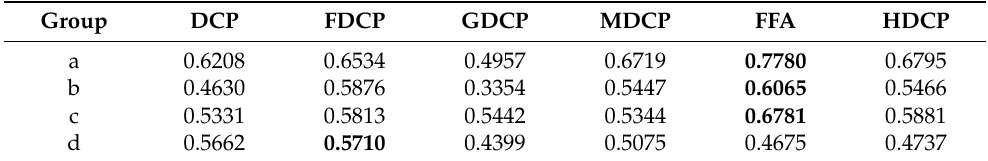
Table 3. SSIM of different algorithms.